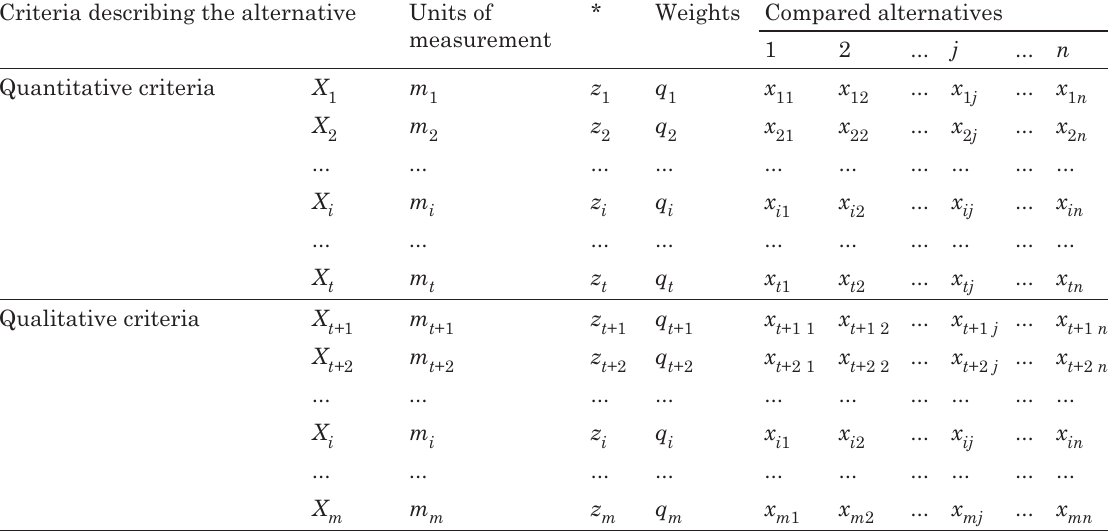
Table 1. Decision-making matrix for maintenance contractor evaluation Criteria describing the alternative Units